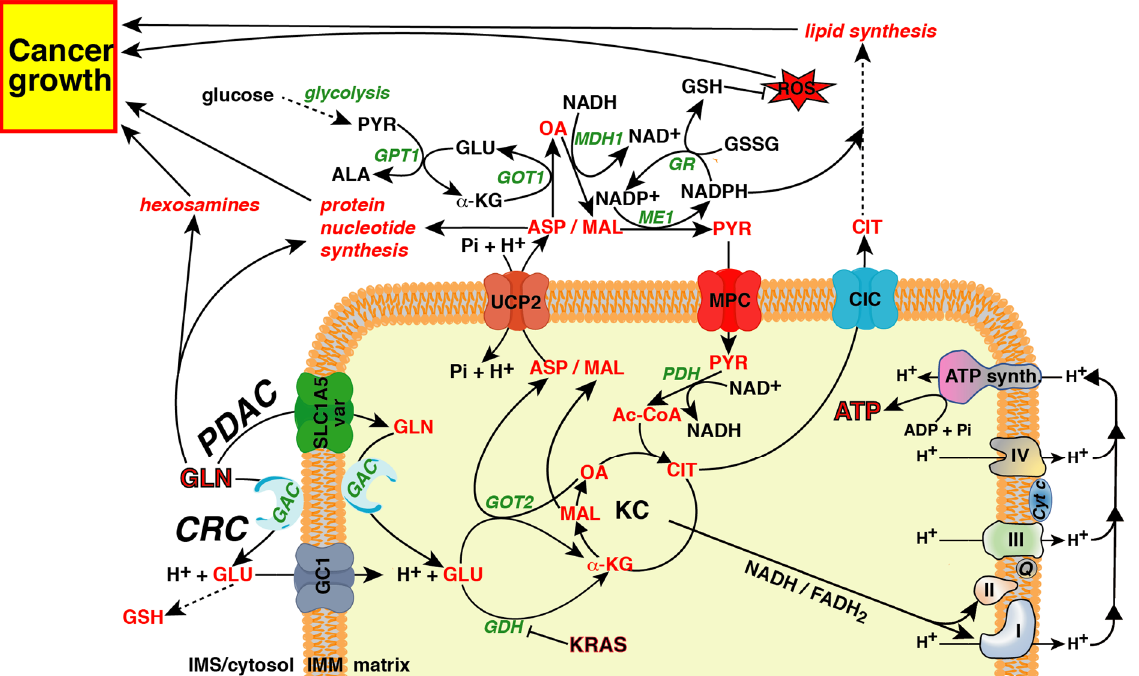
Figure 2. A bird’s eye view of glutamine utilization by cancer cells. Cancer cells can use the carbon skeleton and reduced nitrogen of glutamine to synthesize non-essential amino acids, hexosamines, reduced glutathione (GSH), nucleotides, proteins and lipids. Aspartate and malate produced in the matrix can be used in the cytosol for NADPH production, reducing power for the biosynthetic processes and redox homeostasis. The carbon skeleton of glutamine produces reducing equivalents in the KC (NADH and FADH 2 ) which can be re-oxidized in the electron transport chain, producing chemical energy (ATP). ASP, aspartate; GLN, glutamine; GLU, glutamate, Pi, phosphate; OA, oxaloacetate; MAL, malate; α -KG, α -ketoglutarate; CIT, citrate; GSH, reduced glutathione; GSSG, oxidized glutathione; PYR, pyruvate; Ac-CoA, acetyl-CoA; ALA, alanine; Q, coenzyme Q; PDAC,